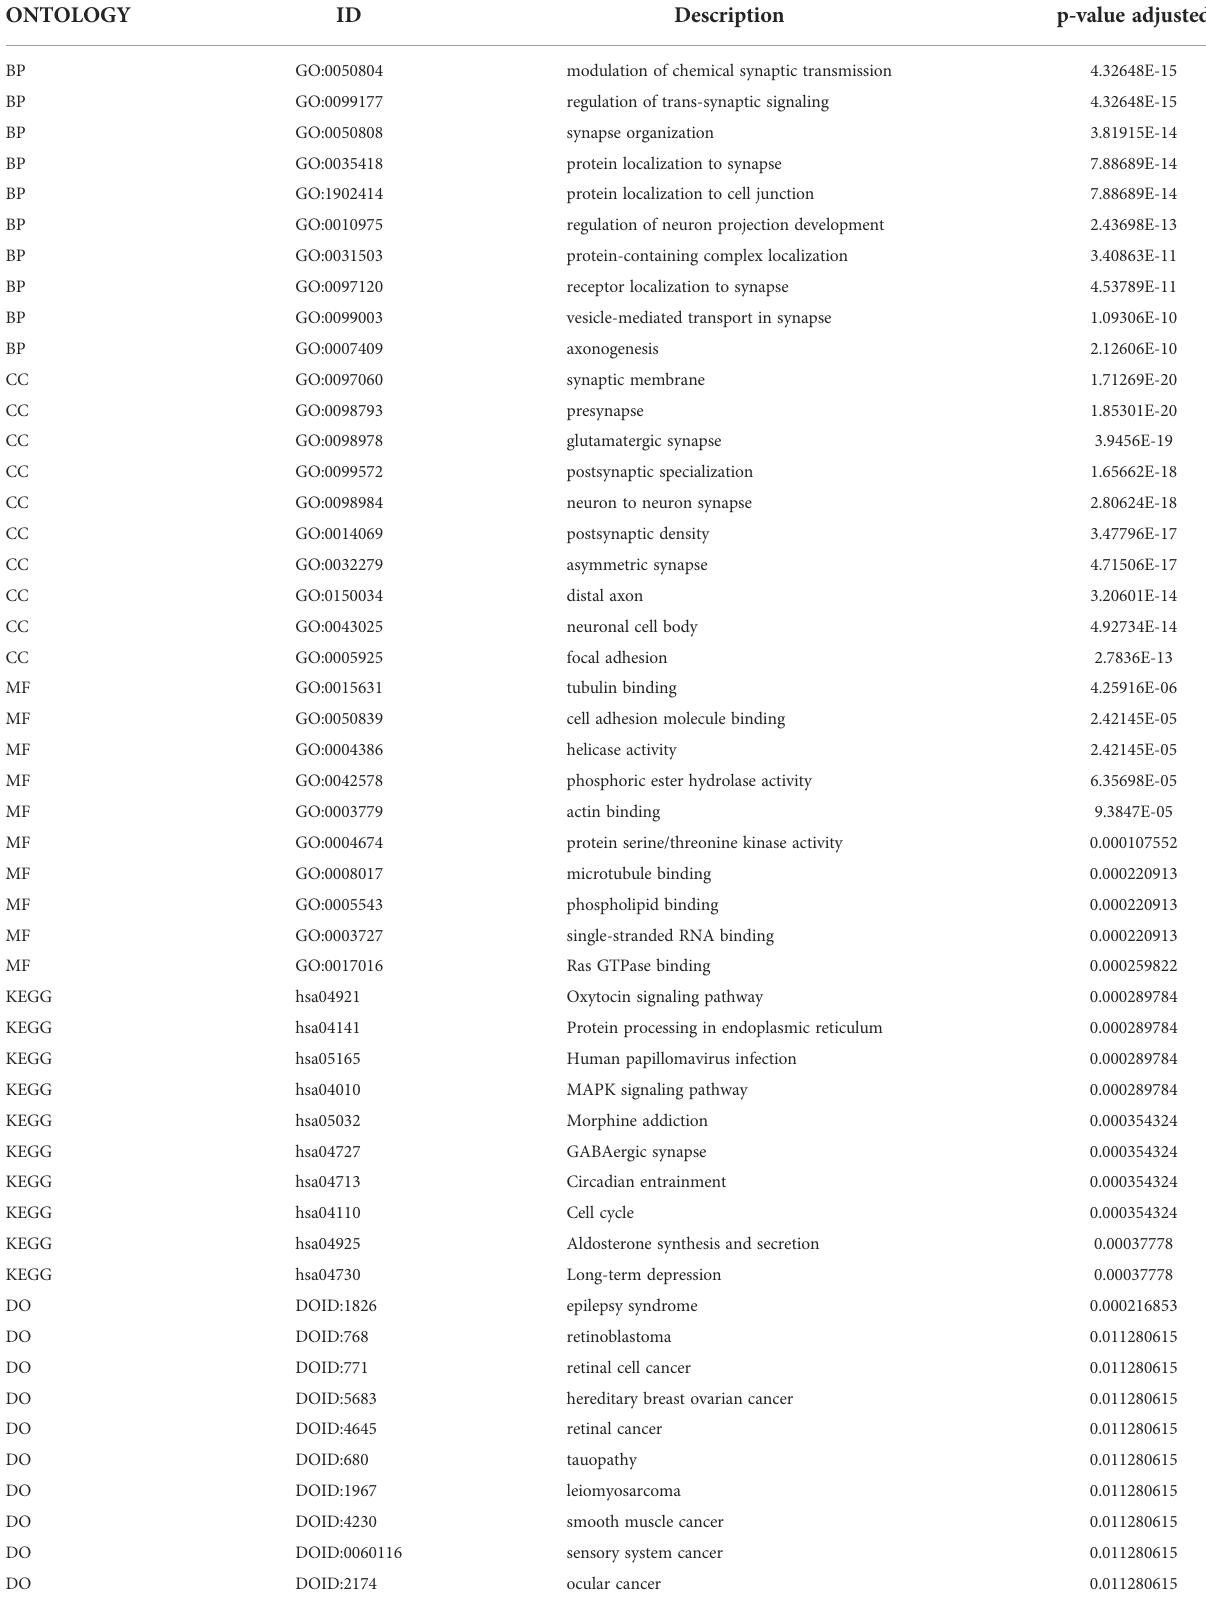
TABLE 2 DEG enrichment analysis between glioma tissue and tumor tissue.